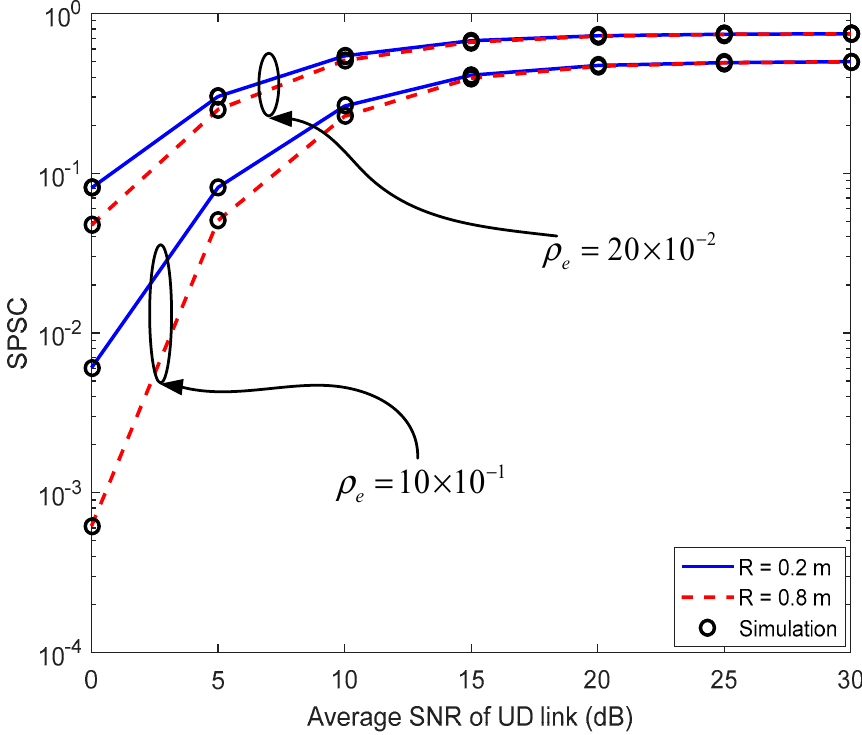
Figure 6. Effect of eavesdroppers’ density ρ e and R on the network SPSC when γ BU = 5 dB and γ UE = 10 𝑑𝐵 .